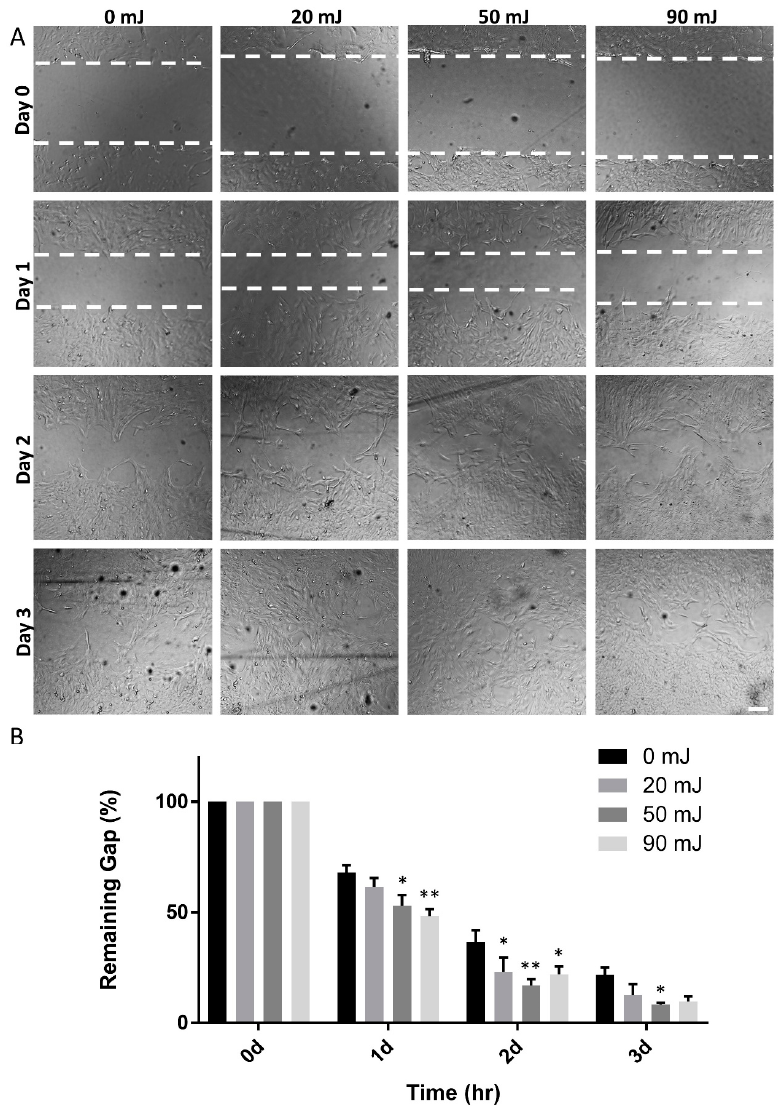
Figure 2. NTP treatment of astrocytes resulted in increased cell/process infiltration. ( A ) Phase-contrast images showing astrocyte infiltration into the gap area 0–3 days post-treatment with 0 mJ, 20 mJ, 50 mJ, and 90 mJ plasma. Dashed lines in images on day 0 and day 1 were added to assist visualization of scratch boundaries. Scale: 250 µ m. ( B ) Astrocyte infiltration was significantly increased over time, as expected. Interestingly, one day post-treatment with 50 mJ and 90 mJ of plasma led to significant astrocyte infiltration into the gap area, two days following treatment, 20 mJ, 50 mJ, and 90 mJ plasma treatment all led to significant reduction in mean gap distance, and three days post-treatment, only 50 mJ plasma resulted in reduced mean gap distance when compared to time-matched untreated control cultures (bars represent standard error of the mean (SEM); * p < 0.05; ** p < 0.01).